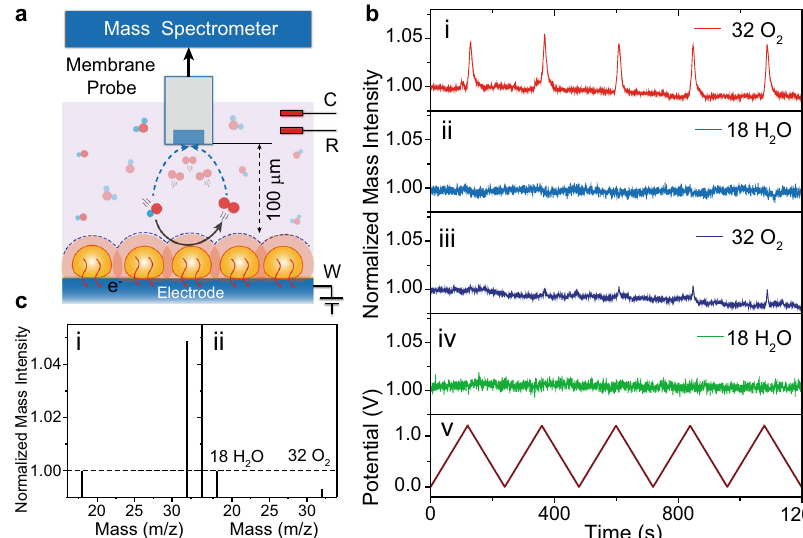
Fig. 3 Potential-dependent mass spectrometry of dissolved oxygen. a Schematic of in situ differential electrochemical mass spectrometry. b Dynamic mass intensity of O 2 and H 2 O analyzed by in situ DEMS during cyclic voltammetry in the potential range from 0 to 1.10 V on working electrode Cu/glass carbon disc (i, ii) and glass carbon disc (iii) and (iv), respectively, in a home-made micro-electrochemical cell in 0.1 M KOH solution, at a scan rate of 0.01 V s − 1 . c The mass spectra during dynamic potential scan on the working electrode Cu/glass carbon disc (i) and glass carbon disc